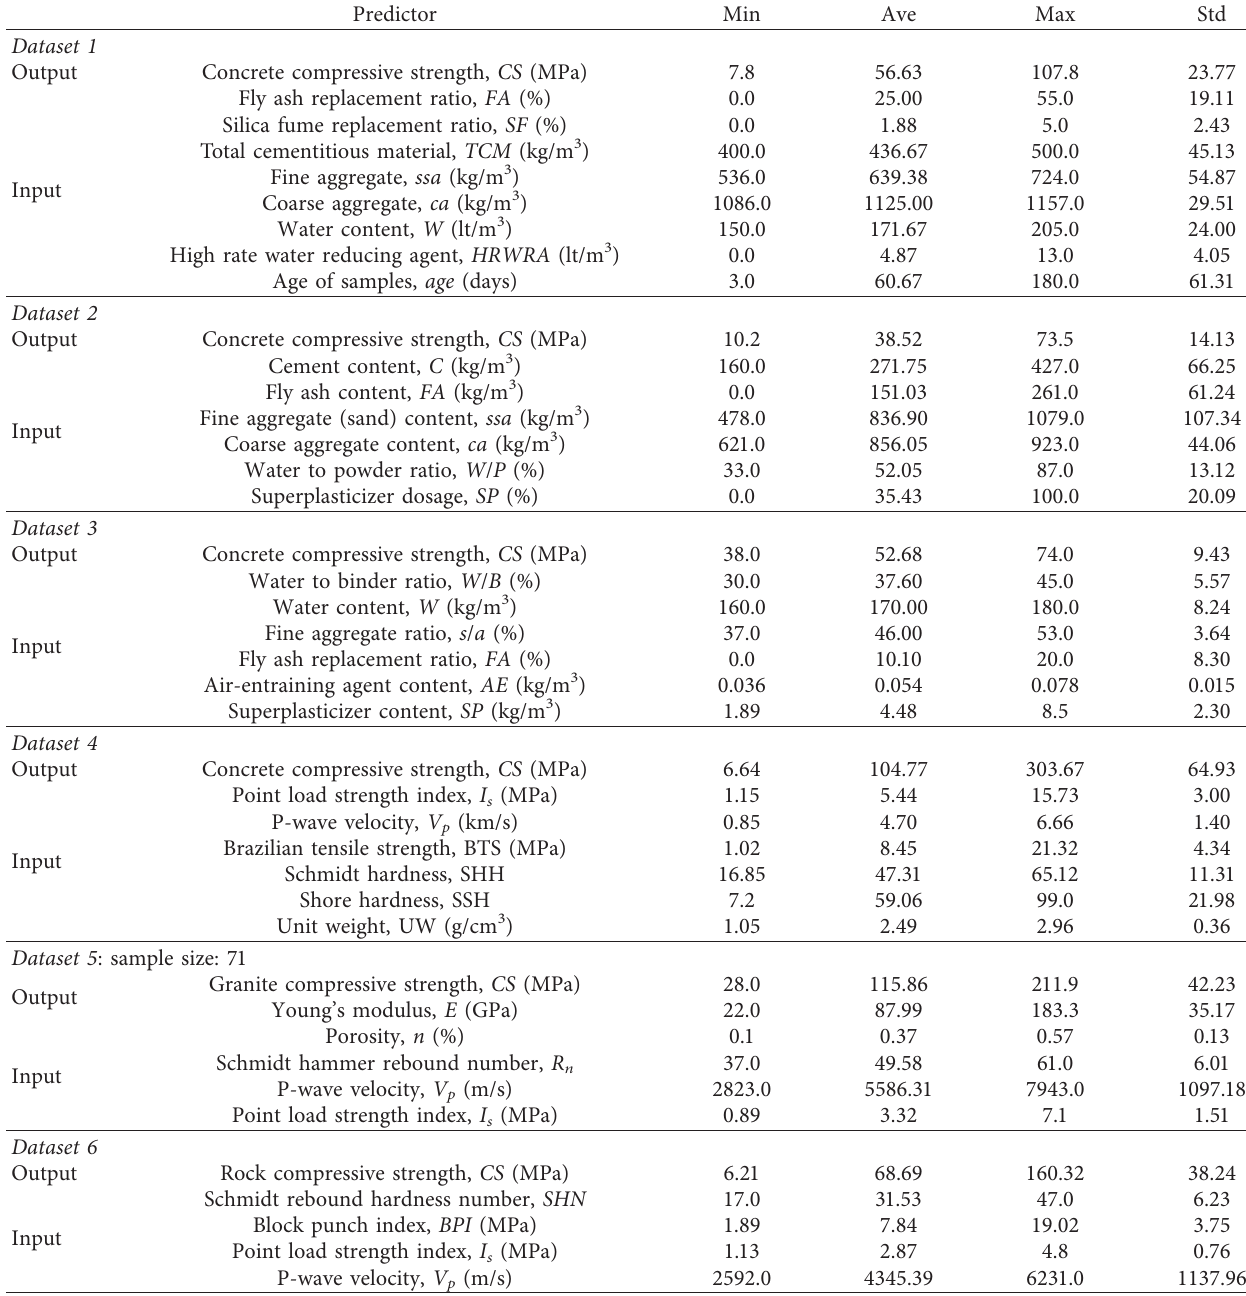
Table 2: Descriptive statistics of